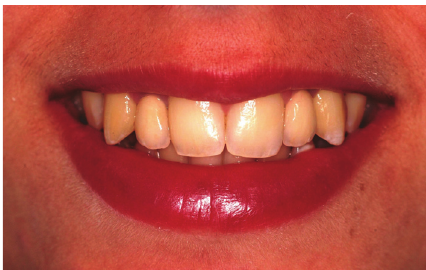
Figure 1: Initial clinical aspect showing the relationship between sharp maxillary canines and lips. Incisal thirds of the canines are projected in the vestibular direction, compromising tooth align- ments and the harmony of smile.